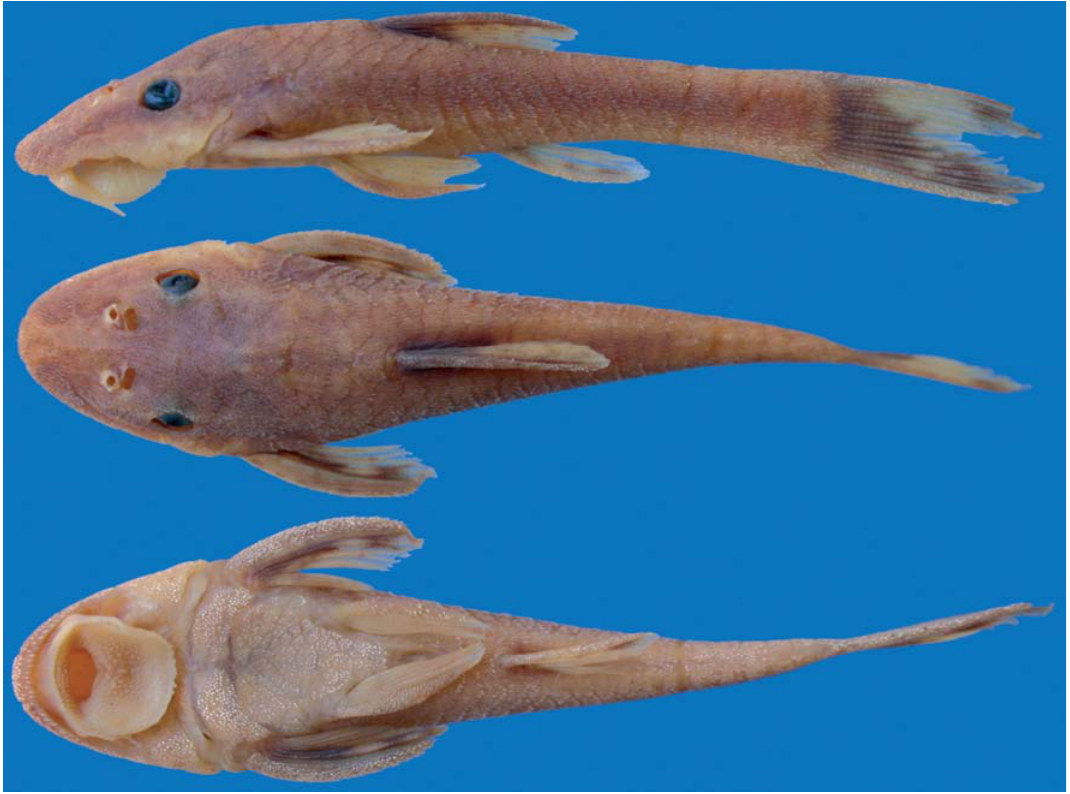
Fig. 5. Parotocinclus bidentatus , holotype MNRJ 27962, 34.8 mm SL. Brazil: Rio de Janeiro State: rio Pirapetinga (left bank tributary of rio Paraíba do Sul),